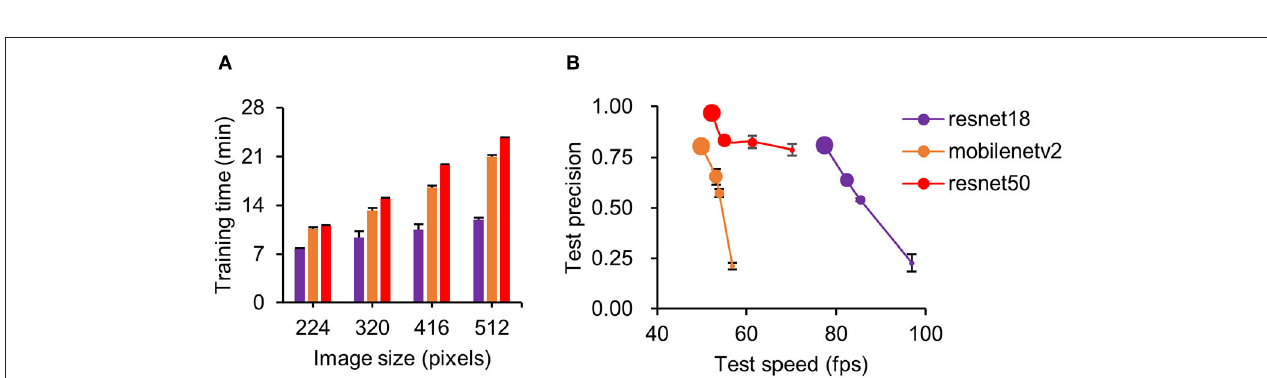
FIGURE 2 | Performance comparison of three pretrained deep neural networks. (A) Comparison of training time with different image sizes for three neural networks. Training time increased with image size for all networks. Of the three, resnet50 took the longest time for all image sizes. (B) Detection precision plot against training speed for three neural networks at different image sizes. Data point diameter in (B) represents the image size from 224 (smallest), 320, 416, and 512 pixels (largest). Note that because of over-fitting, resnet50 is unable to train at an image size of 512 pixels; 480 × 480 images were used instead. Detection precision increased for all networks with increasing image size. In our training model, resnet50 at 480 pixels was used for all